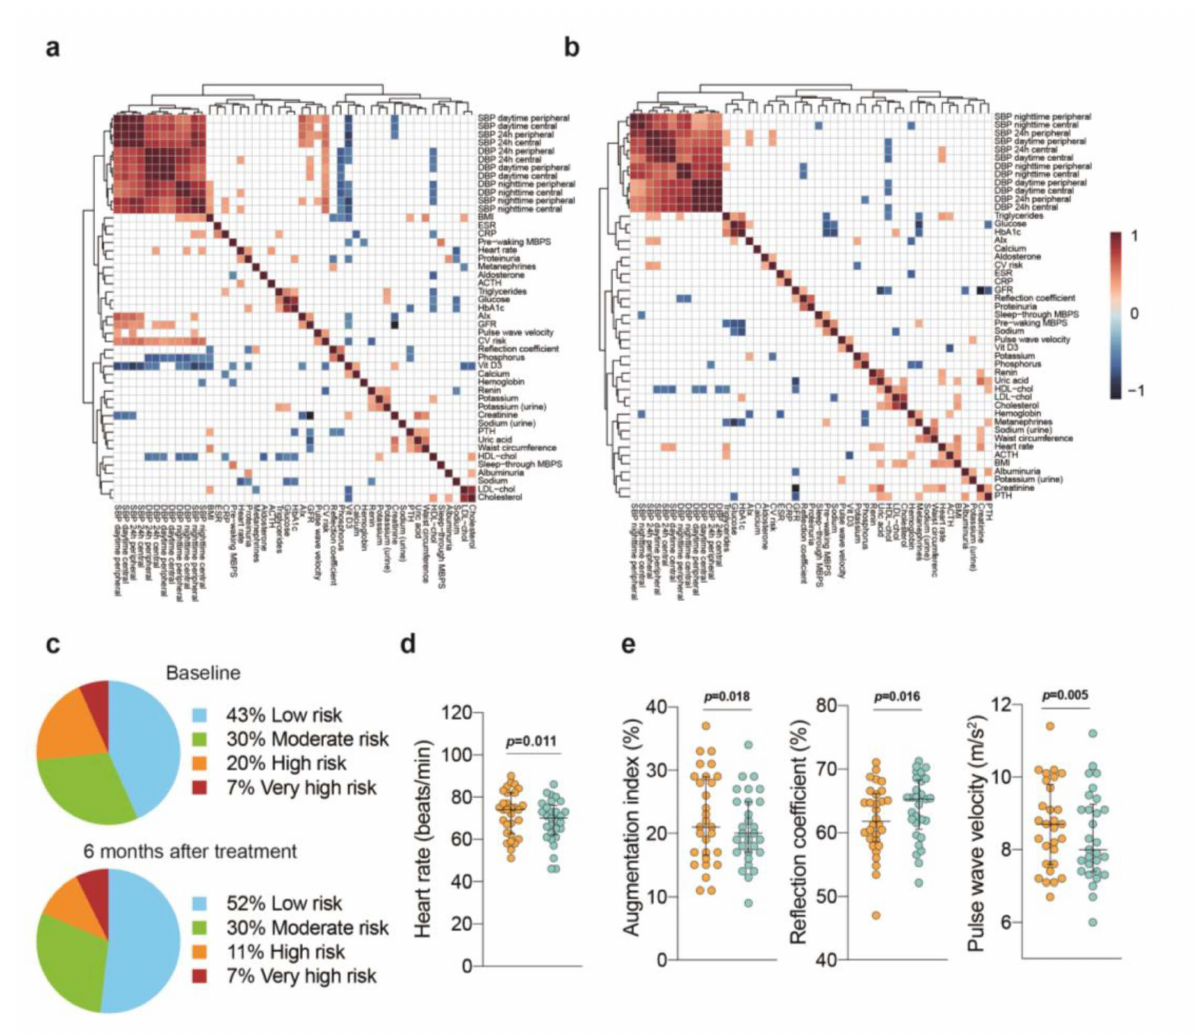
Figure 2. Potential relevance in cardiovascular risk. ( a ) Correlation matrix indicating significant associations between BP and variables associated with cardiovascular risk, which disappeared after the intervention ( b ). Consistently, assessment methods showed decreased risk ( c ). Heart rate ( d ) and surrogates for arterial stiffness ( e ) also diminished after the